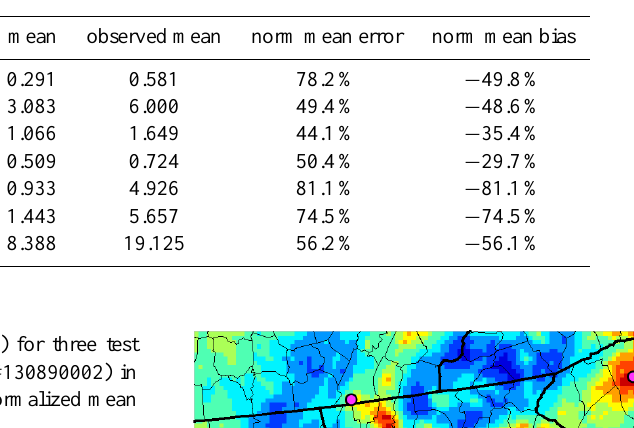
Table 2. Comparison of TC1 model results (in µgm − 3 ) to monitor observations from the 11 CSN monitors (see locations of these monitors in Fig. 2) in June and July 2002.